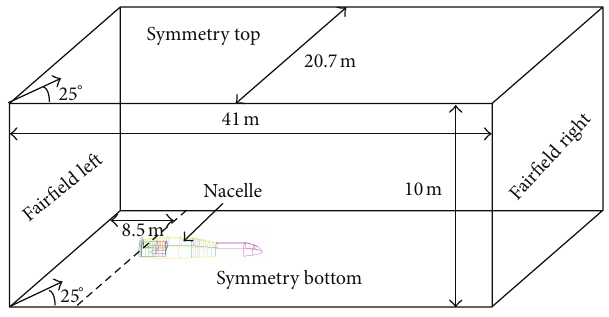
Figure 13: Intake field geometry.